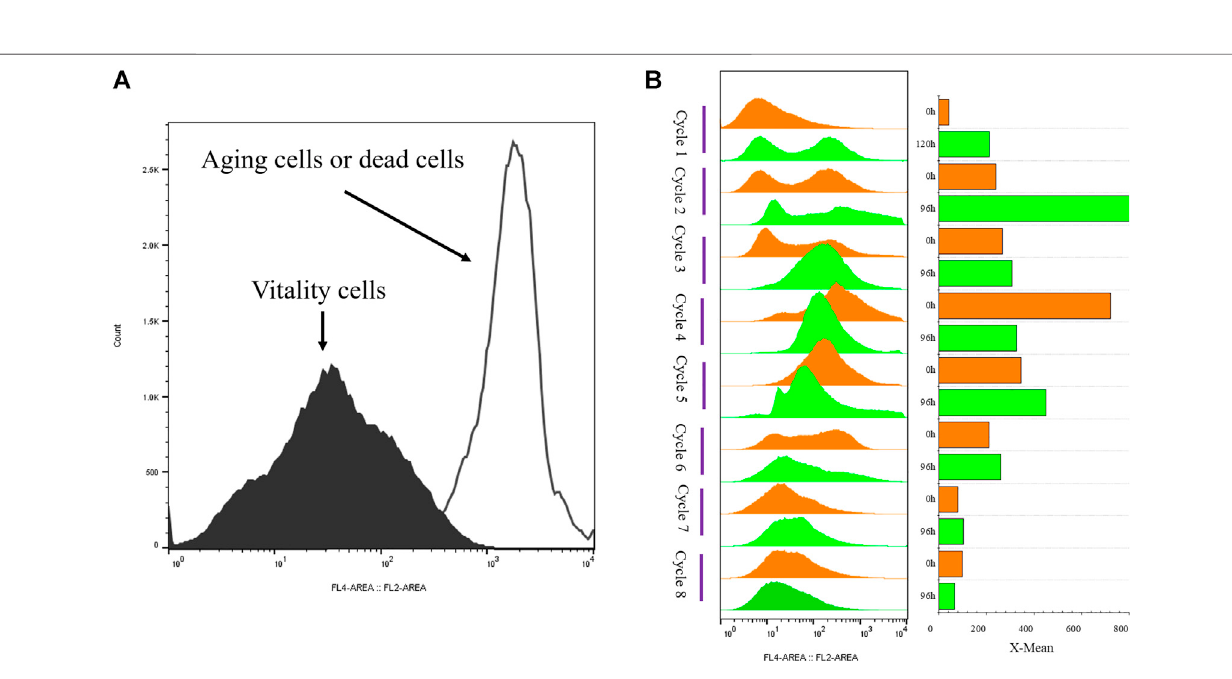
Frontiers in Bioengineering and Biotechnology |